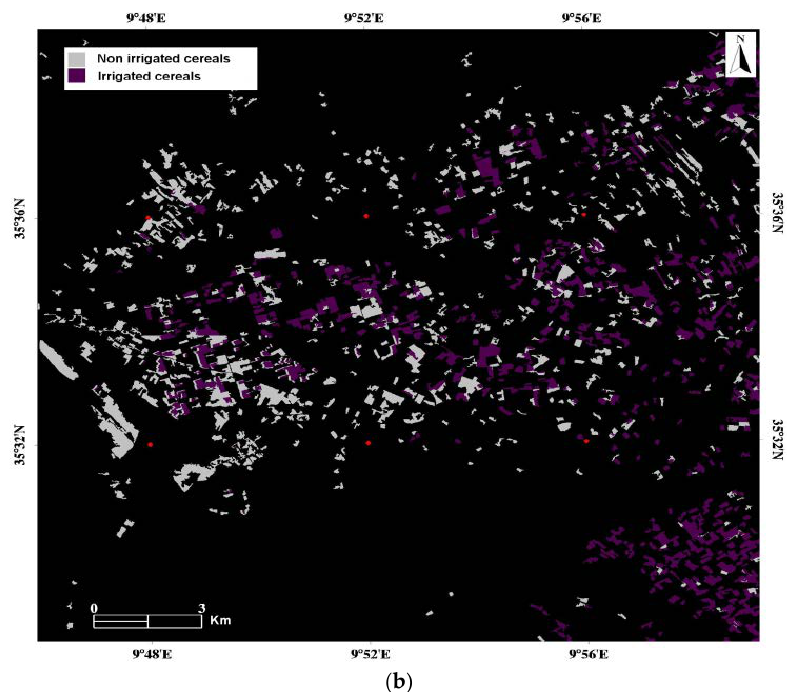
Figure 5. ( a ) Segmented image produced for the 2010/2011 agricultural season; ( b ) Land-use map of irrigated and non-irrigated cereals for the 2010/2011 agricultural